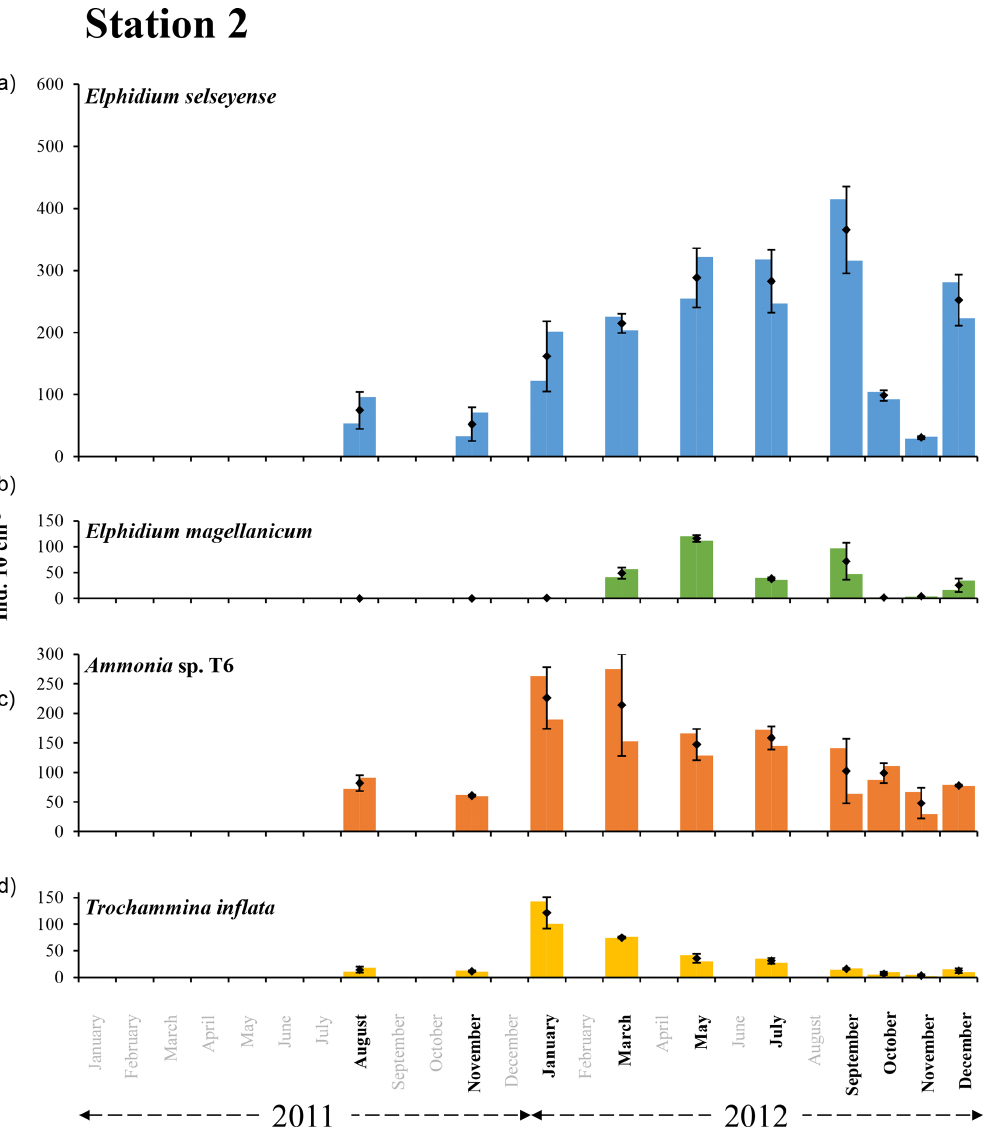
Figure 6. The bars represent the living foraminiferal abundances for the two replicates for Elphidium selseyense (a) , Elphidium magellan- icum (b) , Ammonia sp. T6 (c) and Trochammina inflata (d) at station 2 in 2011 and 2012. The mean abundances (diamonds) and standard deviations (black error bars) were calculated for the two replicates. All abundances values are for the 0–1cm layer and were standardised to 10cm 3 . Months when foraminiferal communities were investigated are indicated in bold. Scales were chosen in order to facilitate comparison with station